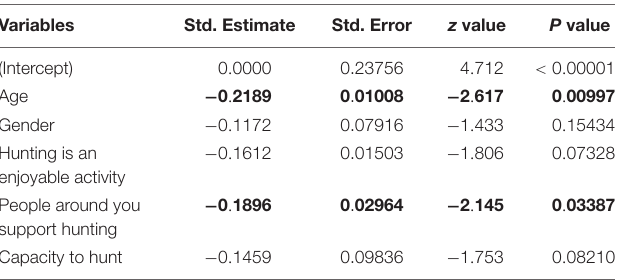
TABLE 3 | Results for GLM investigating predictors of self-reported hunting behaviour with lowest AIC value (AIC = 45.074). Variables Std.